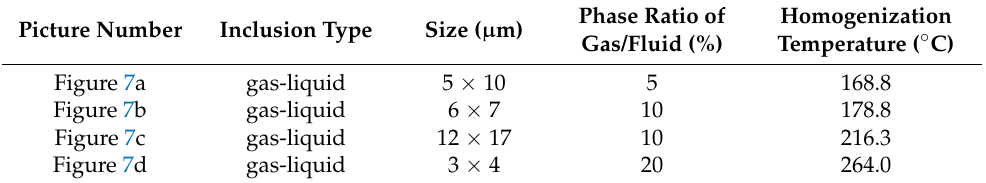
Figure 7. Micrographs of different forms of gas-fluid inclusions ( a – d ) in the quartz druse of Xuanhua- type agate measured for homogenization temperature. Table 1. Characteristics of gas-fluid inclusions in quartz druse of yellow to red Xuanhua-type